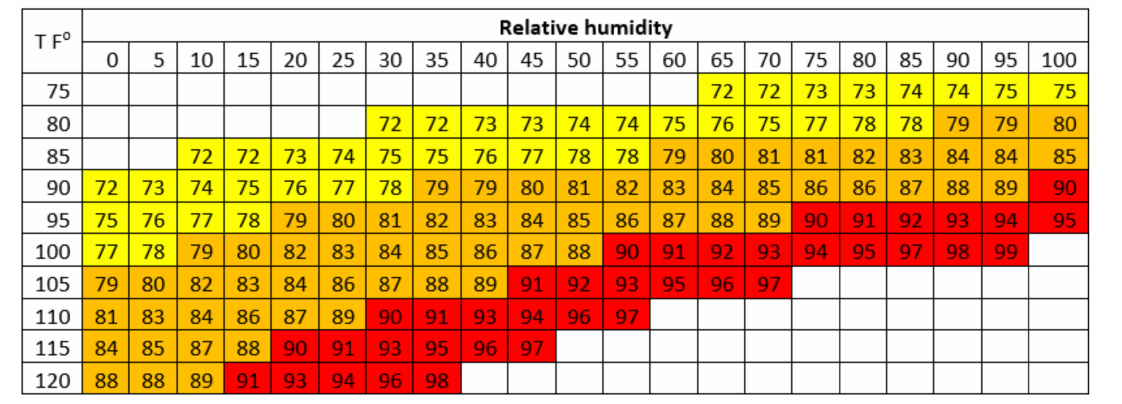
Figure 1. THI for dairy cows. THI 72 to 78 represents mild heat stress; THI 79 to 89 represents moderate heat stress; THI > 89 represents severe heat stress. (Source: Habeeb et al.